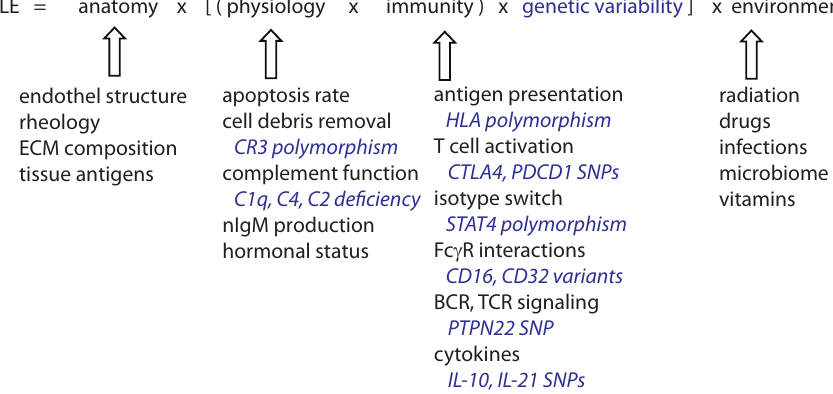
Figure 1. Systemic lupus erythematosus is a heterogeneous group of multifactorial diseases. The development of lupus is influenced by genetic factors, controlling individual variability especially with regard to the immune system and also with regard to physiology (some examples of genetic variability are shown in blue). Anatomical features may determine organ damage and source of autoantigens. Environmental factors can act upon all these elements, and may be the component we could try to modulate with the aim of preventing disease development. SLE, systemic lupus erythematosus; BCR, B-cell antigen receptor; TCR, T-cell antigen receptor; ECM, extracellular matrix; Fc γ R, Fc receptor for